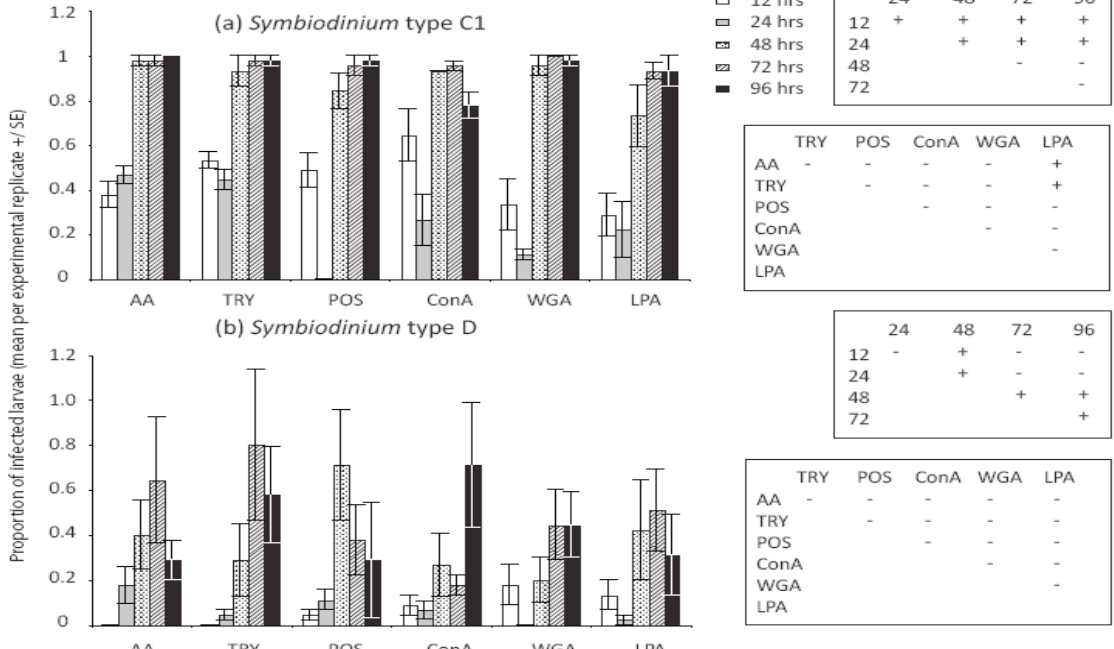
Triticum vulgaris